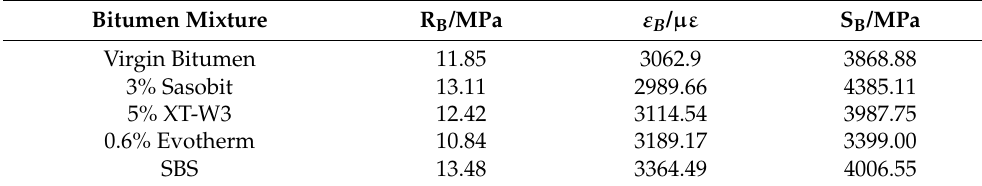
Table 10. Results of the low-temperature small beam bending